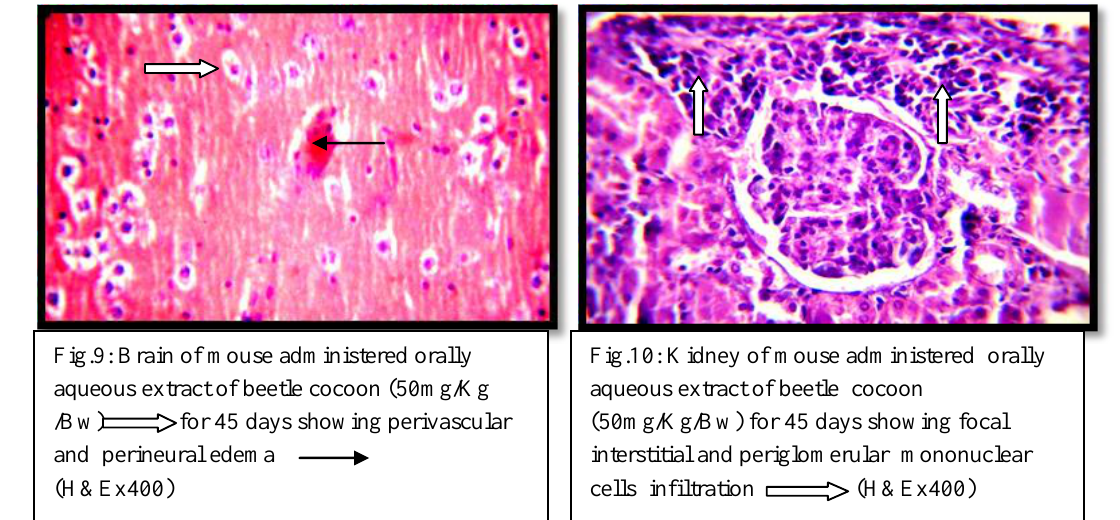
Fig.10: Kidney of mouse administered orally aqueous extract of beetle cocoon (50mg/Kg/Bw) for 45 days showing focal interstitial and periglomerular mononuclear cells infiltration (H&Ex400)